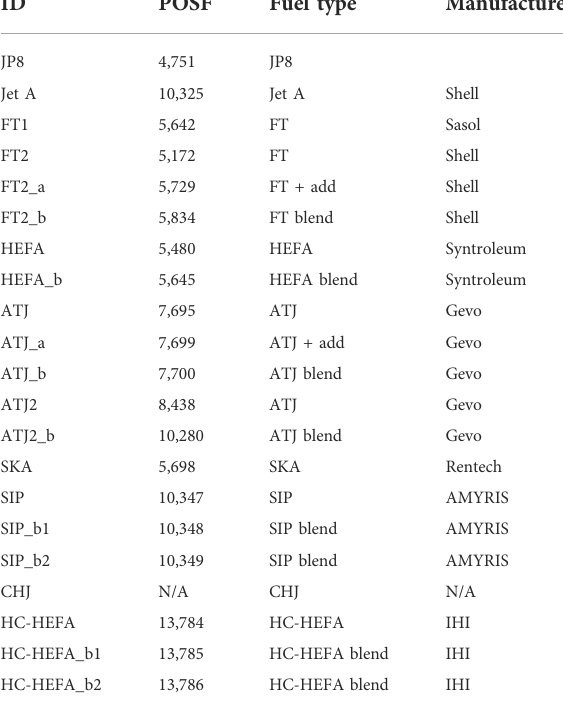
TABLE 5 Fuel identi fi